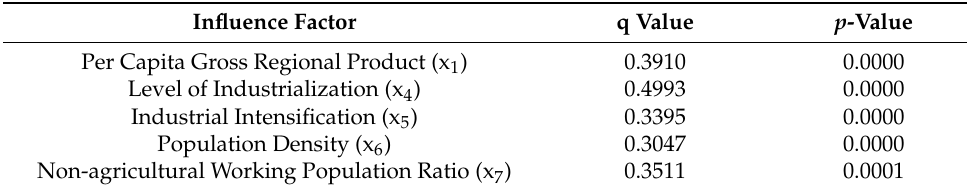
Table 4. Factor q value detection.